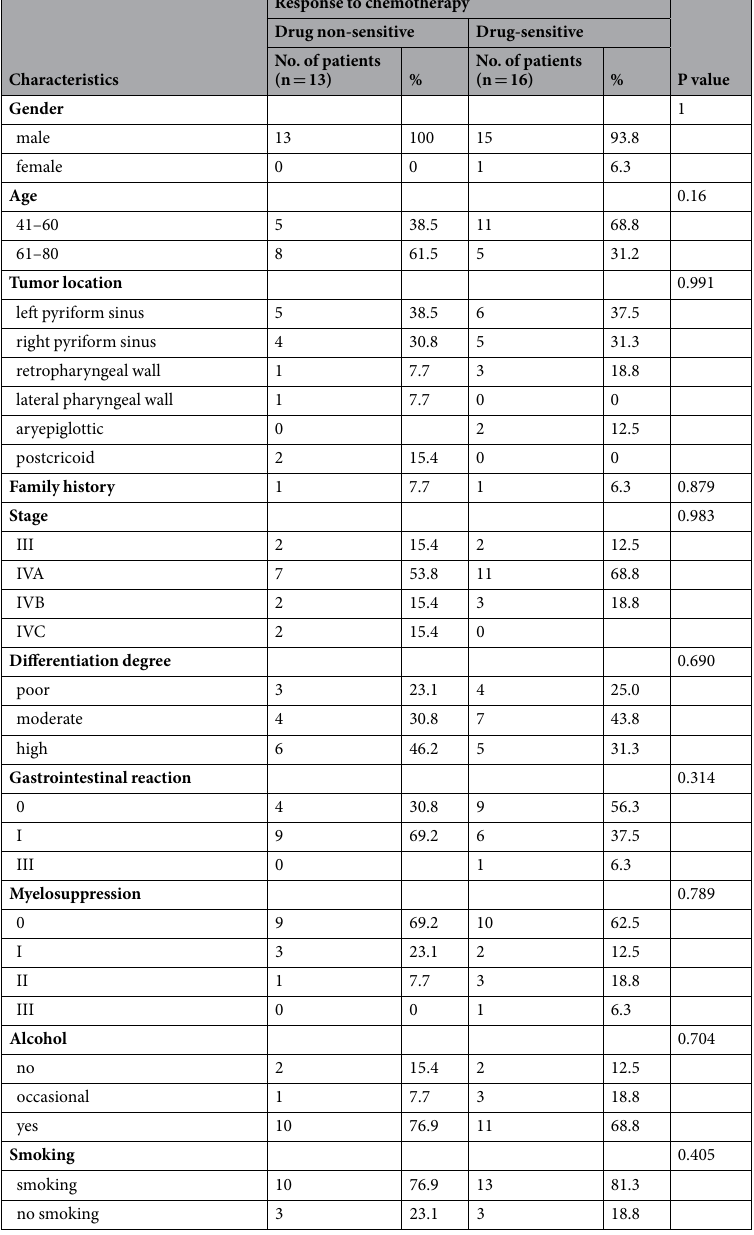
Table 2. Characteristics of